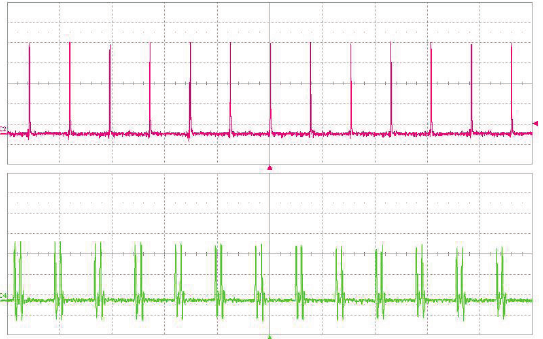
Figure 8. Oscillogram of dual-pulse regime. 1.06 µ m pump (upper trace), PPLN OPO radiation at 1.53 µ m (lower trace). Time scale 10 ns/div.